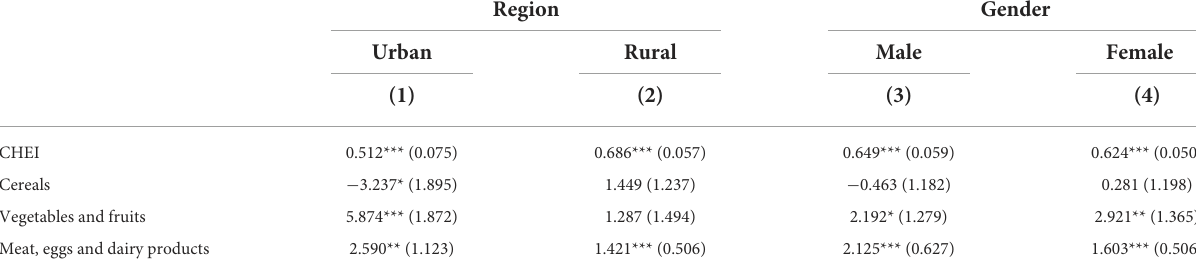
TABLE 7 Estimation of neighborhood effects on dietary behaviors of older adults (with subsamples, fixed effects